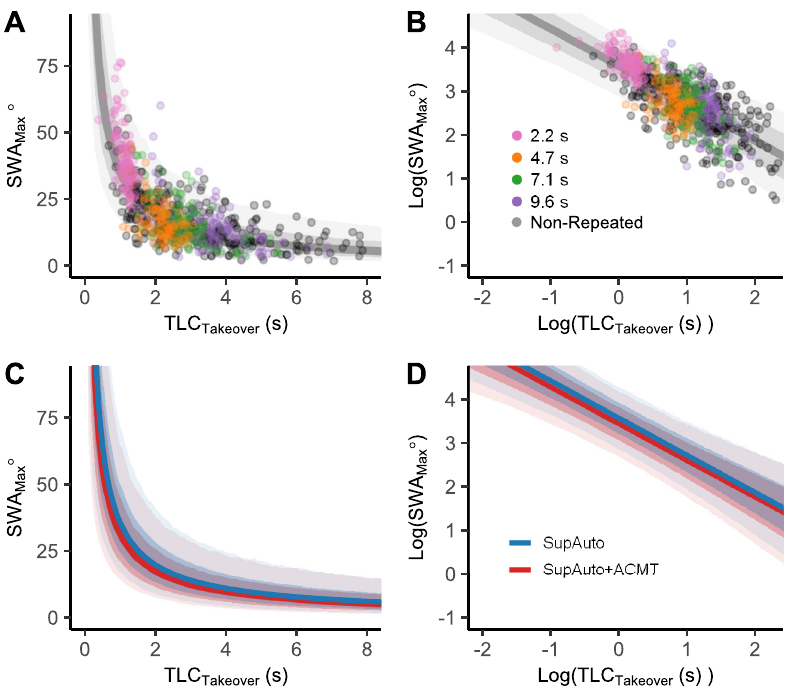
Fig 4. SWA Max . In A) & B) SWA Max is plotted against TLC T for the SupAuto condition, shown in A) raw coordinates and B) log-log coordinates. The Repeated conditions are coloured in both A) & B) to indicate how the log-log